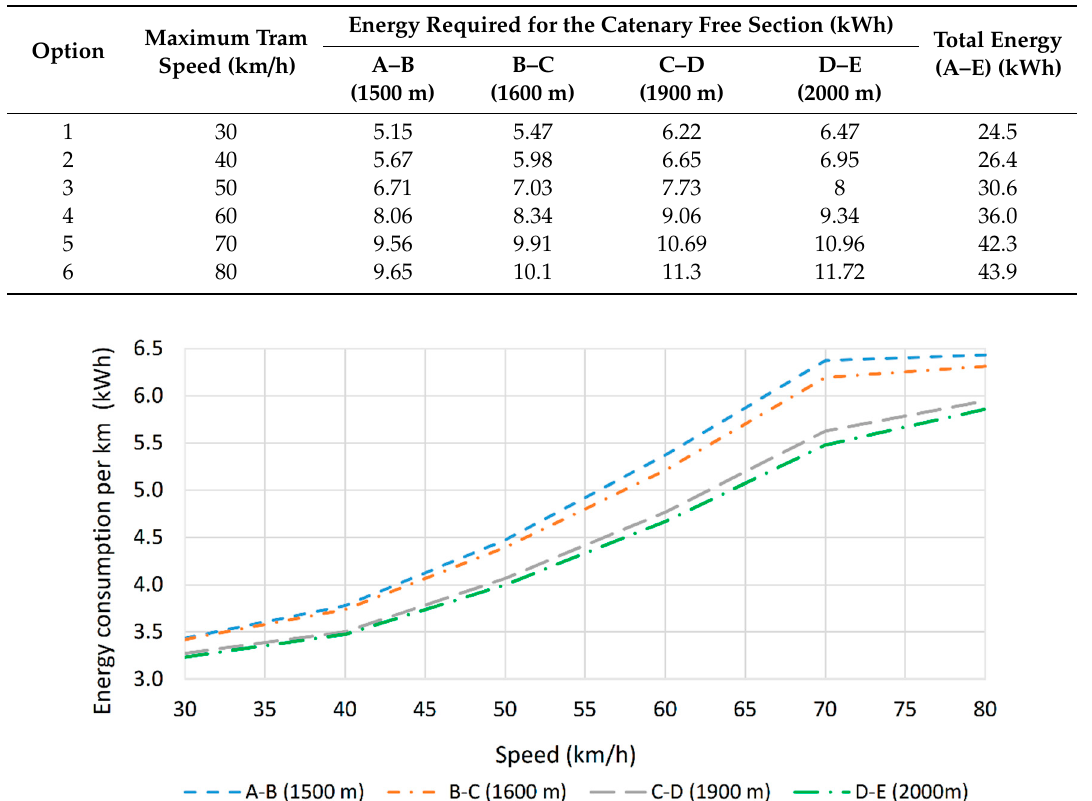
Figure 12. Tram energy consumption per km for a catenary free section.